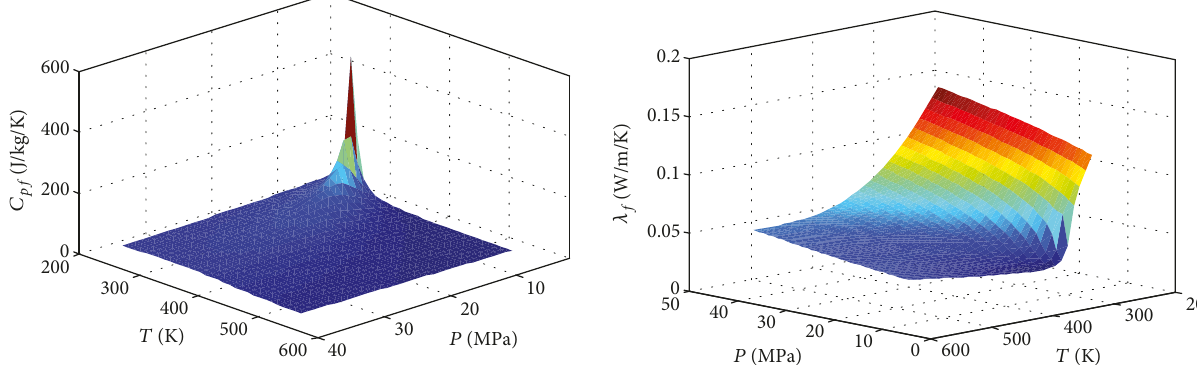
Figure 2: Variation of C